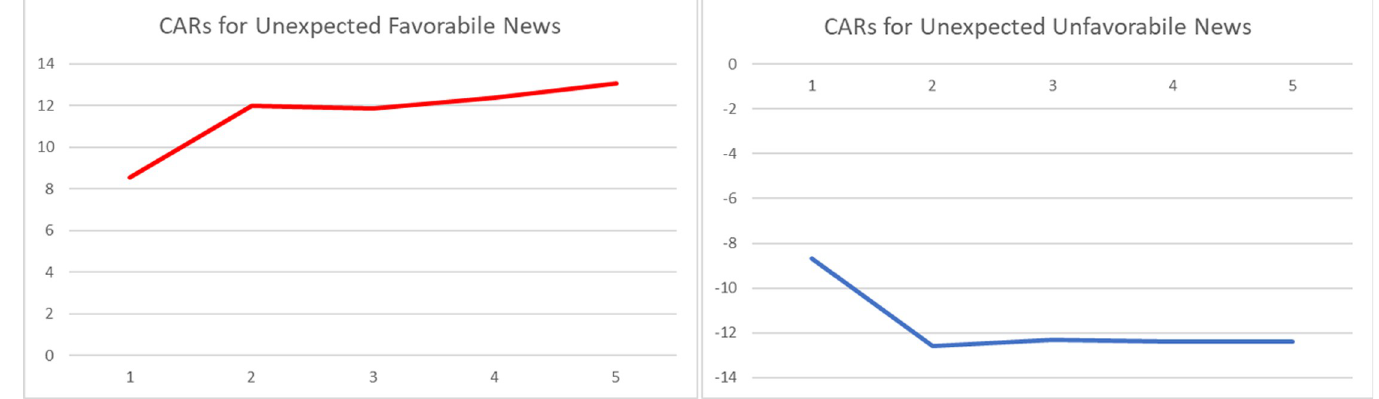
Fig 1. Graphs of daily CARs during a 5-day window following arrival of unexpected event (whole period– 1.01.2011 to 12.08.2021).